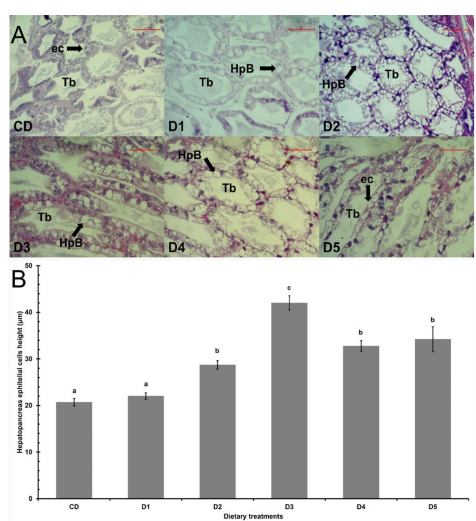
Figure 1. Hepatopancreas histology of shrimp L. vannamei fed control diet and 50% fishmeal replace- ment diets. ( A ) Light micrographs of longitudinal sections (4 µ m) of hepatopancreas stained with hematoxylin and eosin, showing a well-organized structure. Arrows indicate normal structures of tubule epithelial cells including secretory (B-cells) cells. Scale bar: 100 µ m. ( B ) Hepatopancreas epithelial height cells of shrimp. Data are presented as mean ± SE, values with different letters are significantly different ( p < 0.05). Abbreviations: Tubules (Tb), epithelial cells (ec), and B-cells (HpB). CD (200 g/Kg FM), D1 (0.13% DL-MET), D2 (0.06% MET-MET), D3 (0.19% MET-MET), D4 (0.13% DL-MET plus 0.10% B. amyloliquefaciens CECT 5940) and D5 (0.06% MET-MET plus 0.10% B. amyloliquefaciens CECT